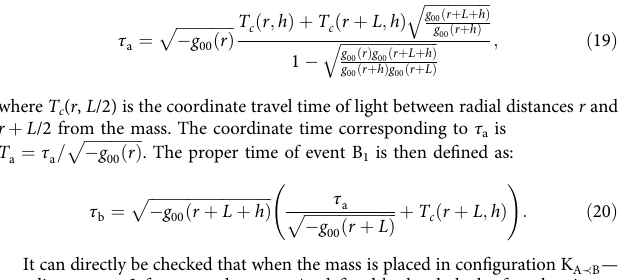
Fig. 4 Space-time diagram of a protocol for disentangling the clocks from the mass. In con fi guration K L + h from b — it is at r from a r + h from b 1 . In K B (cid:2) A 1 and at 1 .The opposite holds for a 2 , b 2 . The initial mass superposition is swapped (after suf